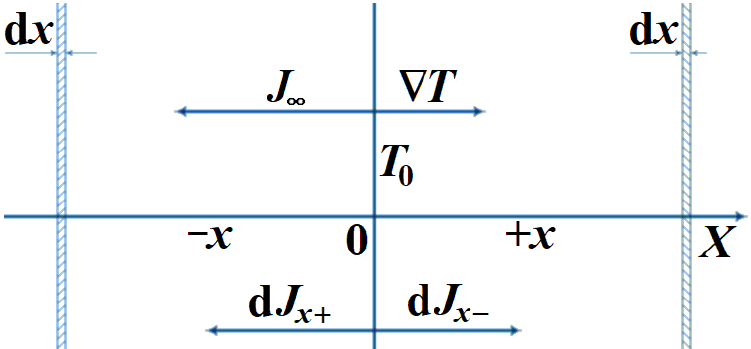
Figure 2. Integrating of radiation contributions from all layers of the